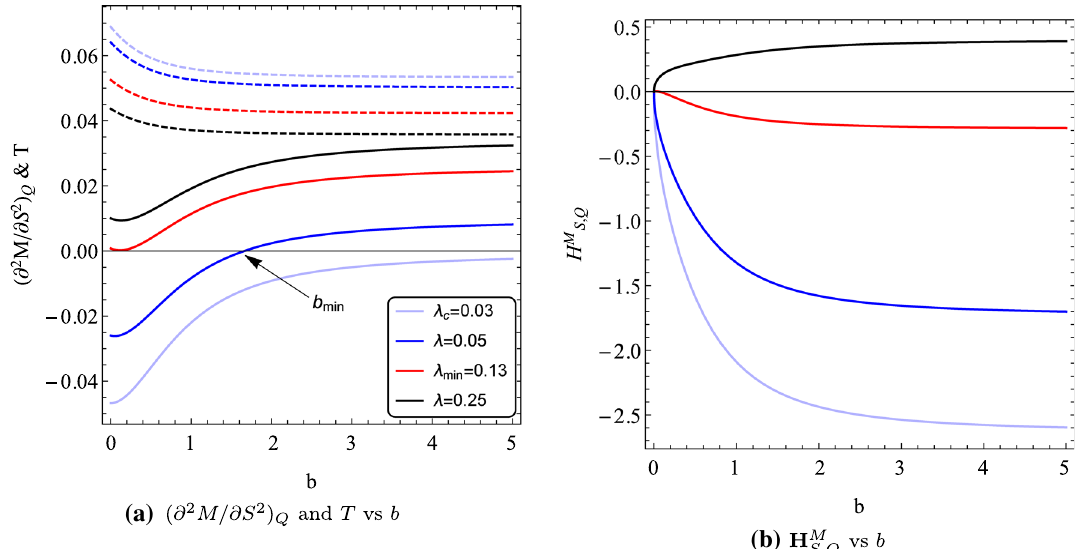
Fig. 4 The behaviors of (∂ 2 M /∂ S 2 ) Q , H M